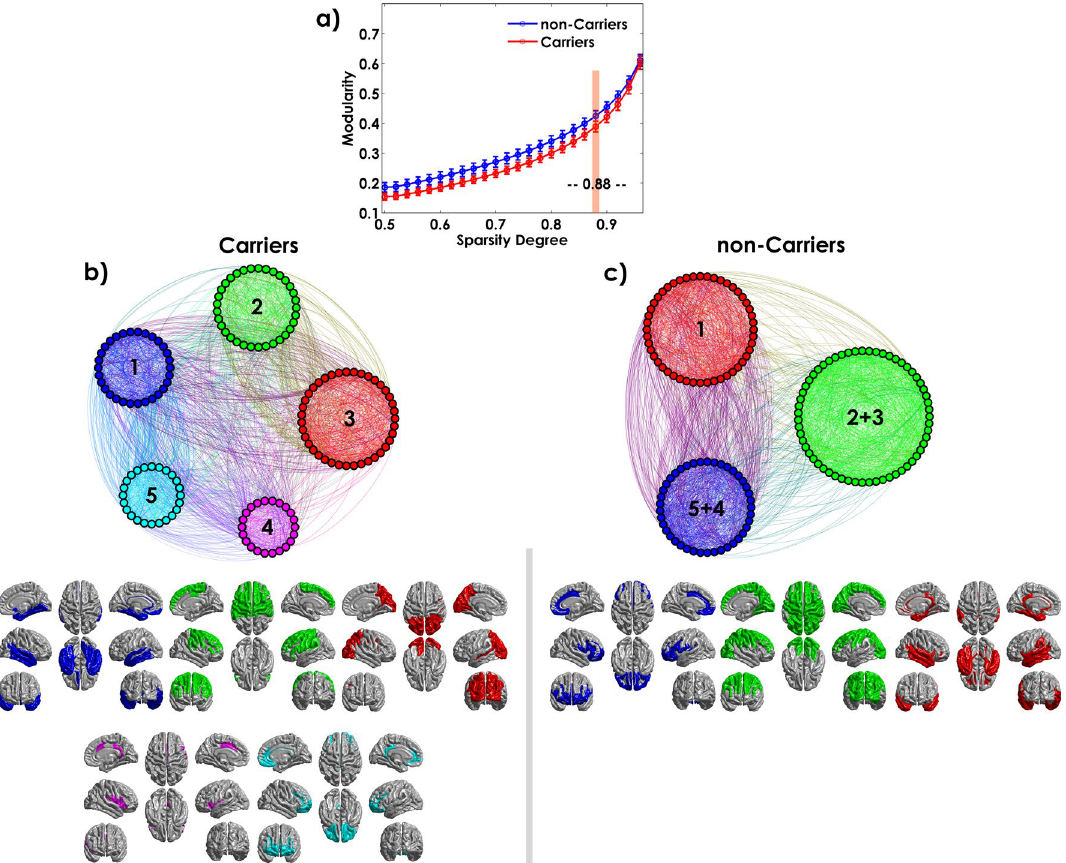
Figure 8. Module distributions for both Carriers and non-Carriers groups estimated using Newman’s spectral community detection algorithm at sparsity degree 0.88. The circular representation of the modules was based on the Gephi package (https ://gephi .org/). Inferior panels show the cortical surface mapping of the modules in both Carriers and non-Carriers groups using the BrainNet Viewer package (http://www.nitrc .org/proje cts/bnv). Each color represents those regions that belong to a specific